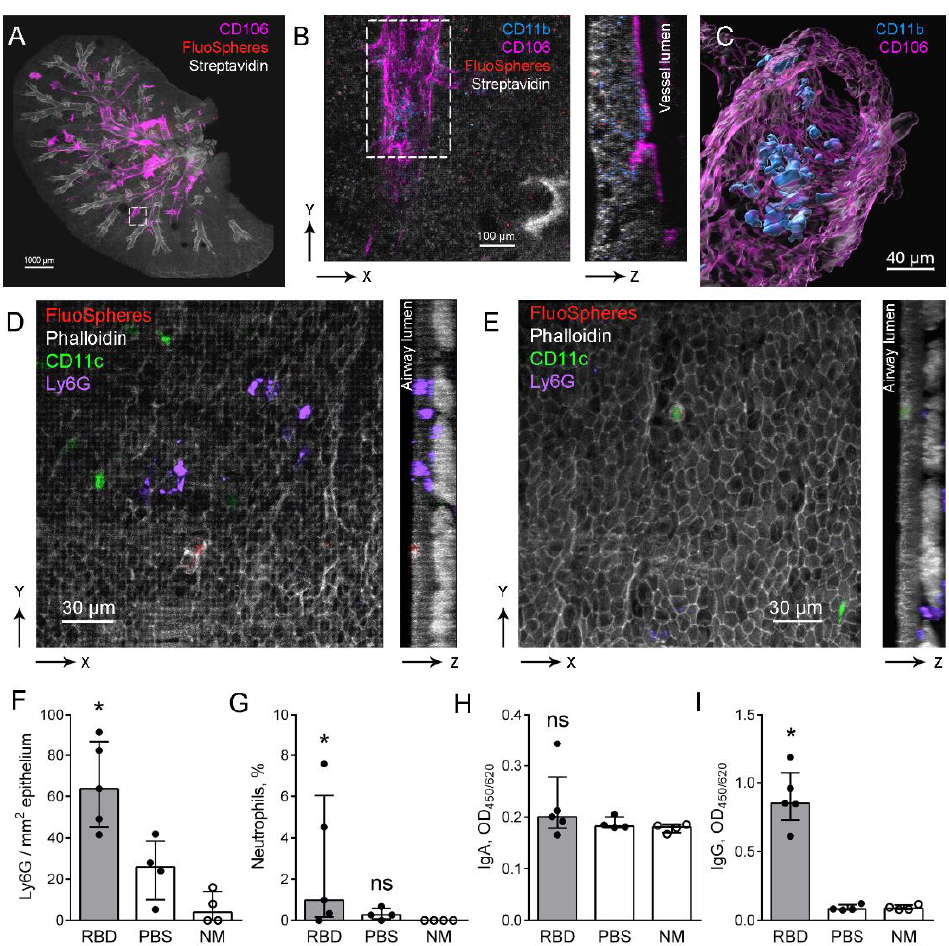
Figure 3. Identification and quantitative analysis of neutrophils in the airways and the lung vessels. ( A ) The representative three-dimensional image of the lung of mouse that received i.p. RBD injections and the o.ph. application of 100 nm particles in the RBD solution. The large vessels (CD106, magenta), the airways (Streptavidin, grayscale), and 100 nm particles agglomerates (FluoSpheres, red) are represented via volume rendering. Scale bar 1000 µ m. ( B ) The higher magnification of the region boxed in ( A ) demonstrating the vessel (magenta) and CD11b + cells (light blue) as the frontal (left image) and the lateral (right image) projections. Scale bar 100 µ m. ( C ) The image of the region boxed in ( B ) showing the vessel and CD11b + cells via surface rendering. Scale bar 40 µ m. ( D , E ) Representative three-dimensional images of the regions of conducting airway mucosa of the mouse with induced RBD-specific antibodies ( D ) and of the PBS-injected mouse ( E ) 24 h after the application of 100 nm particles in the RBD solution. 100 nm particles (FluoSpheres, red), epithelial and smooth muscle cells (phalloidin, grayscale), neutrophils (Ly6G, light blue) and CD11c + cells (green) are represented as the frontal (upper images) and the lateral (lower images) projections. Scale bar 30 µ m. ( F , G ) The quantitative analysis of neutrophils in the airway mucosa ( F ) or BAL ( G ) of mice that were injected with RBD (gray bars, black circles) or with PBS (open bars, black circles) 24 h after the application of 100 nm particles in the RBD solution, and in intact mice (NM, open bars, open circles). ( H , I ) The levels of IgA ( H ) and IgG ( I ) in the BAL fluids of mice that were injected with RBD (gray bars, black circles) or with PBS (open bars, black circles) 24 h after the application of 100 nm particles in RBD solution, and in the intact mice (open bars, open circles). The data are shown as medians and i.q.r. for n ≥ 4 mice per group. A significant difference between the indicated group and the intact mice was detected using the Mann – Whitney test *: p ≤ 0.05 .